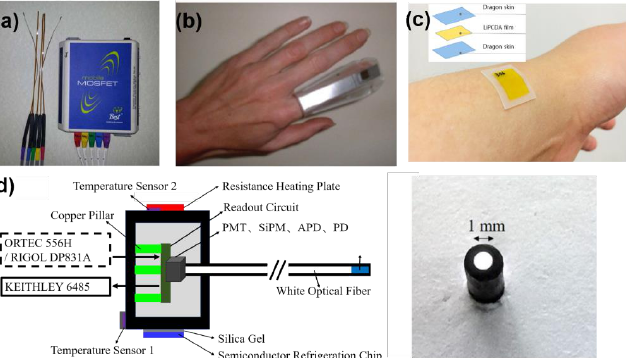
Figure 1. ( a ) MOSFETs from ref. [4] with permission from John Wiley and Sons, ( b ) a finger TLD, adapted from ref. [5] with permission from Elsevier, ( c ) flexible film dosimeter, adapted from ref. [6] with permission from John Wiley and Sons and ( d ) schematic of a fiber dosimeter and a photograph of the polished end-face of a white optical fiber from ref. [7] with permission from Springer.